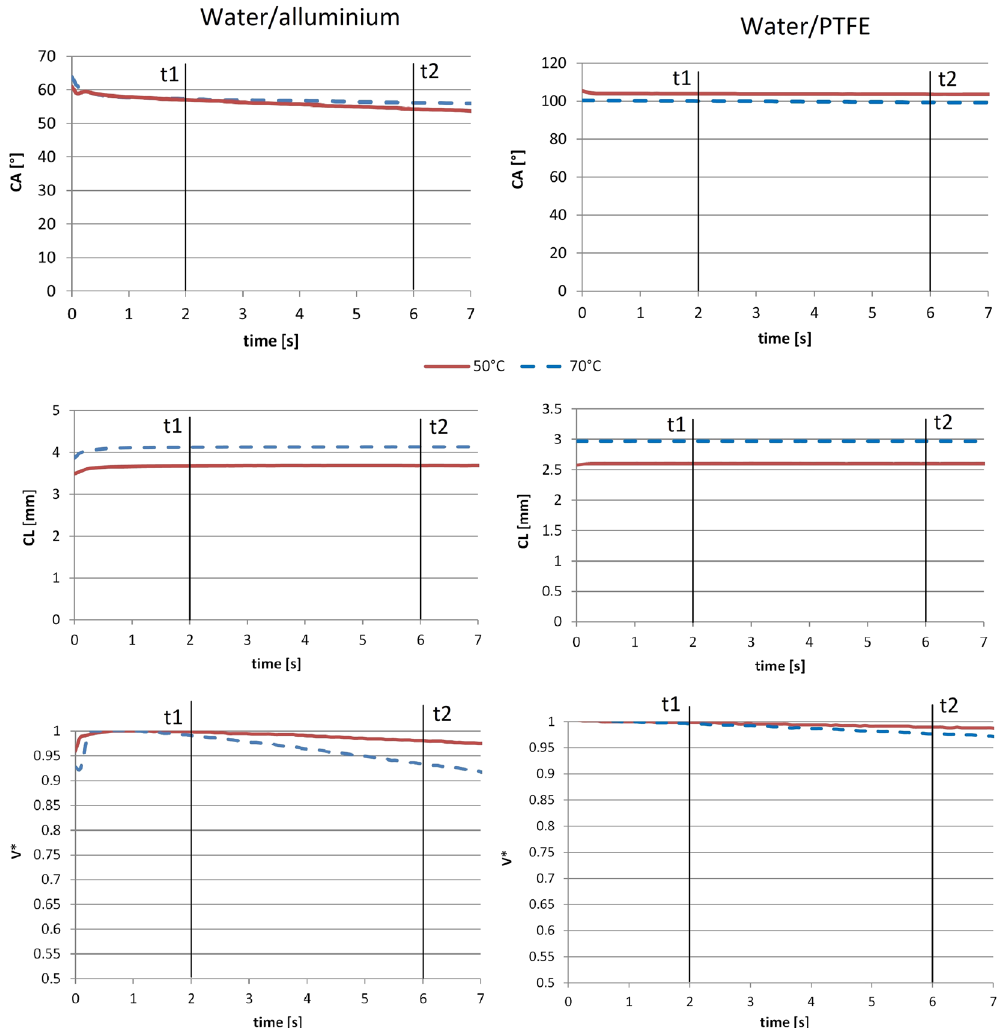
Figure 3. Evolution of the CA of a water droplet contact line (CL) and the non-dimensional volume (V * ) of water drop on aluminium surface (on the left) and water drop on PTFE surface (on the right). Two tested surface temperatures are plotted (50 °C and 70 °C). The ECA is evaluated between t 1 = 2 s and t 2 = 6